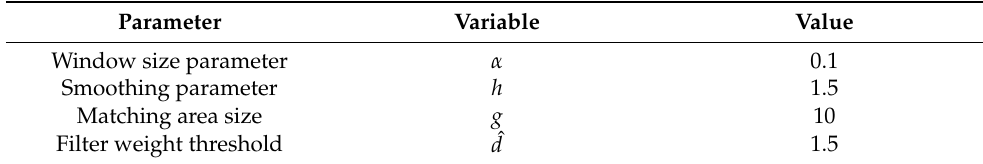
Table 1. Parameter set of proposed modified steering kernel filter.